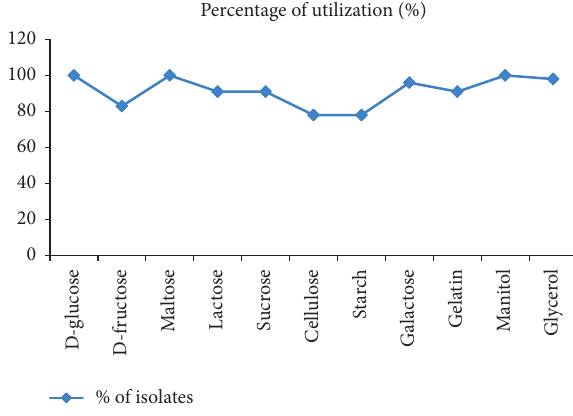
Figure 9: Utilizations of different carbon sources of chickpea rhizobia isolates.